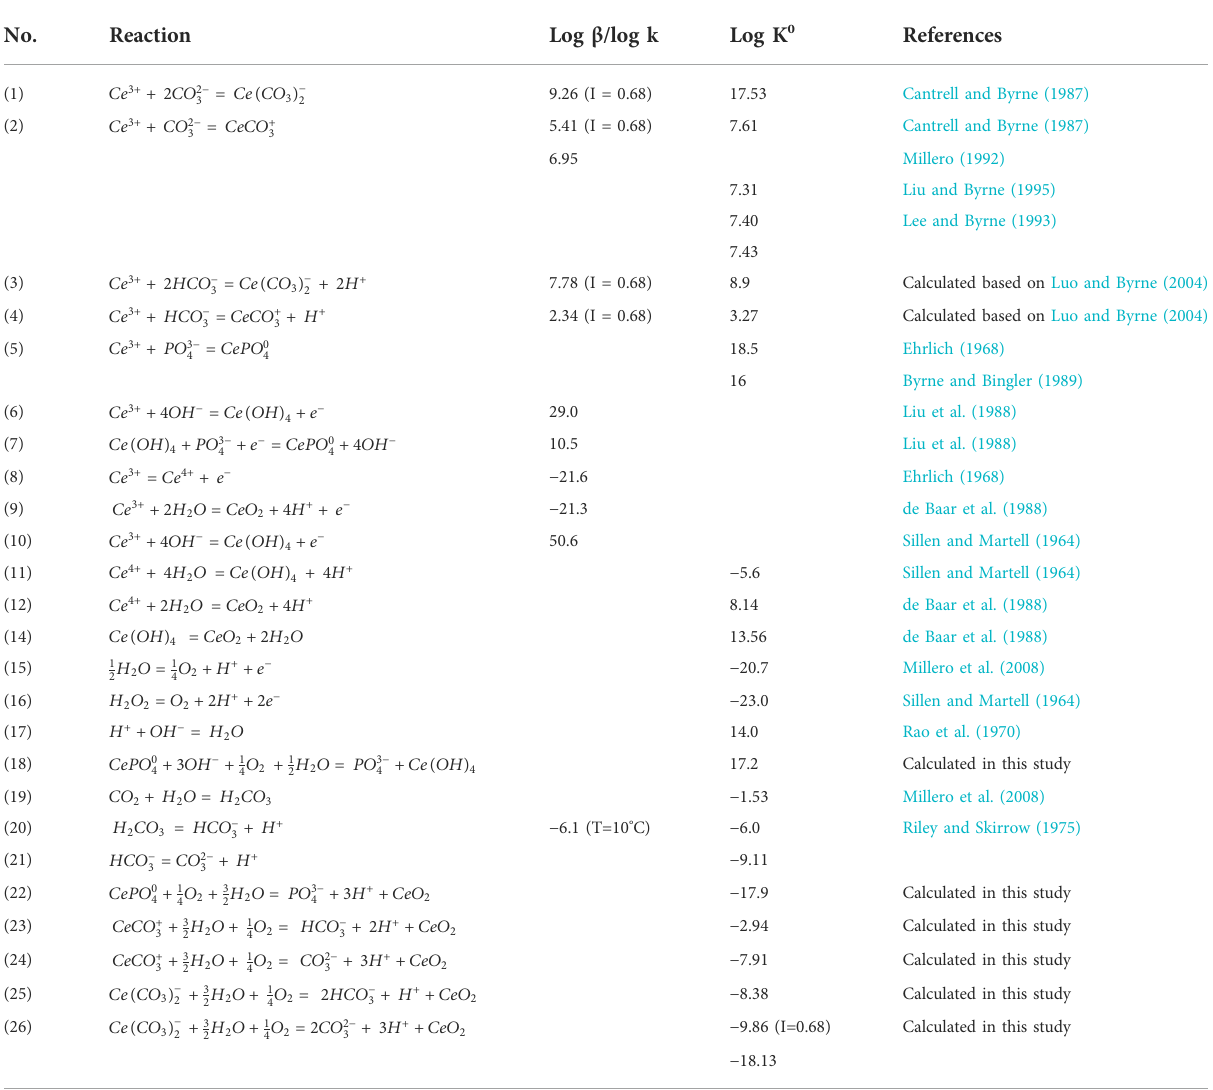
TABLE 2 Selected equilibrium constants of reactions at 25 ° C, atmospheric